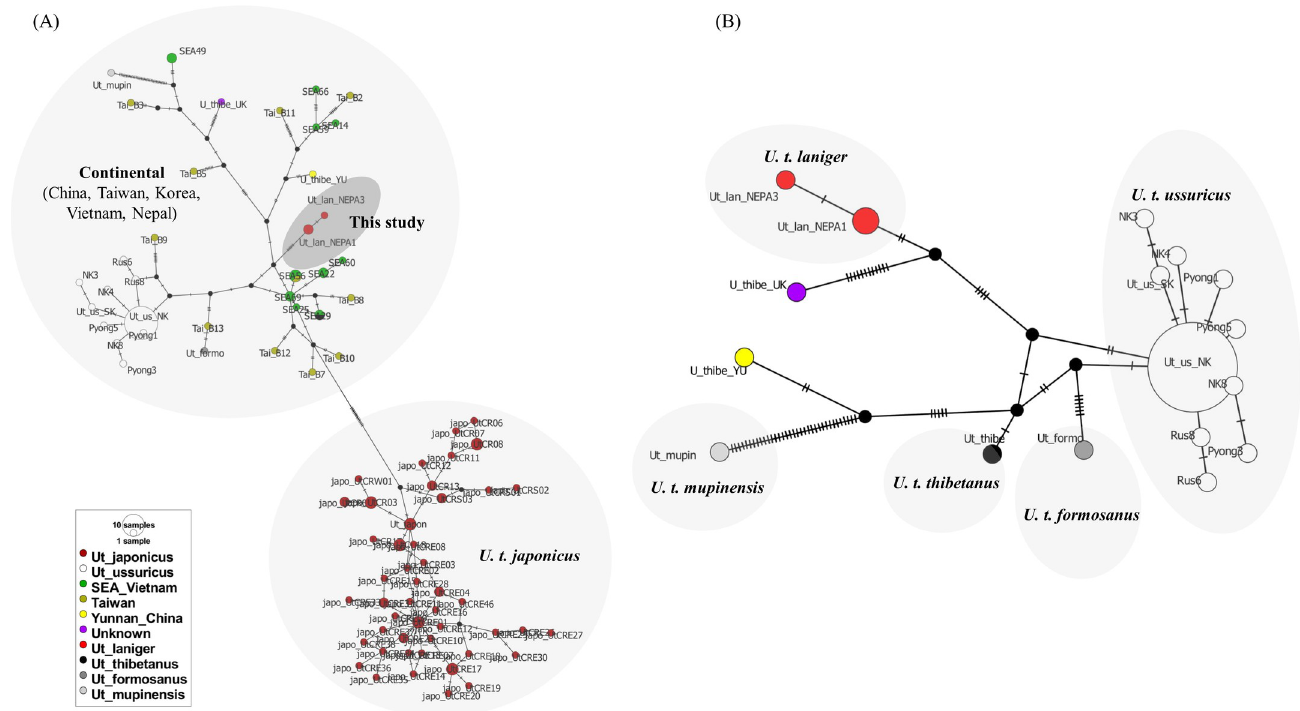
Fig 4. Median joining network based on CR haplotypes by using POPART. A total of 523 positions were included in the final analysis after complete deletion. Network tree was generated using all published haplotypes for 6 subspecies of Asiatic black bears, unknown haplotypes from southeast Asia (Vietnam), Taiwan, Yunnan province of China and unknown origin; (A) for 130 haplotypes of Asiatic black bears and (B) based on continental subspecies of 40 haplotypes after excluding the haplotypes from Japan, Taiwan zoo and Vietnam’s rescue center. The detail information of each haplotypes is presented in S4 Table.